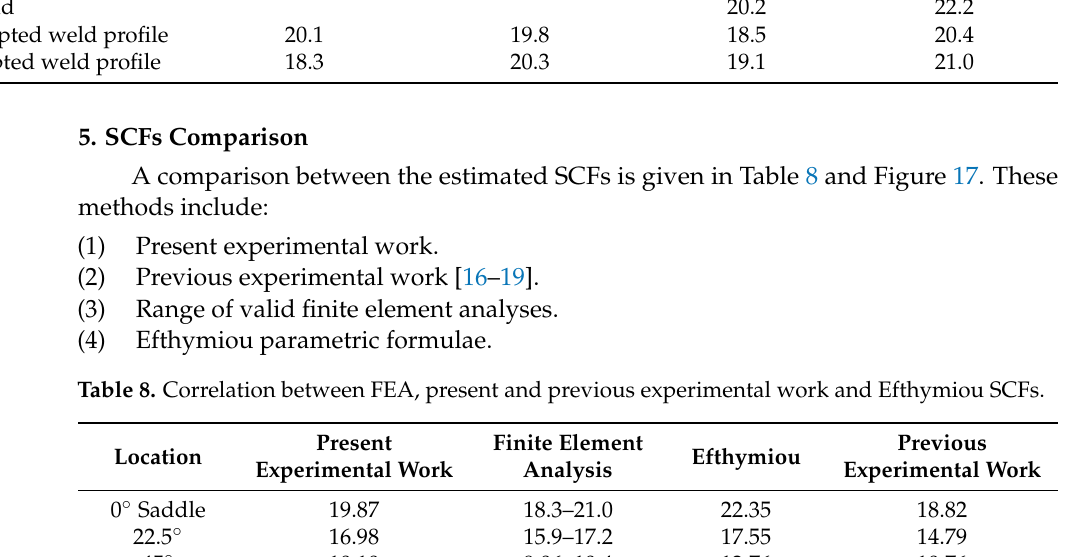
Table 7. SCFs for different weld profiles based on unaveraged principal stresses. Weld Profile